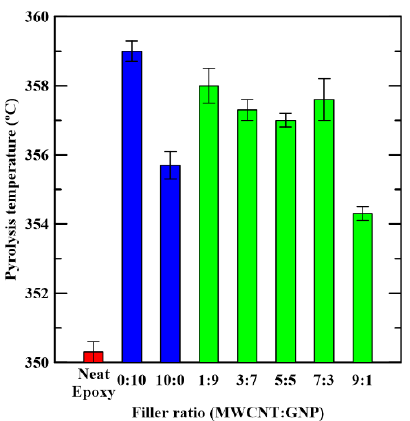
Figure 10. Variation of measured pyrolysis temperatures of the studied nanocomposites T d with the employed filler ratios in the specimen preparation.